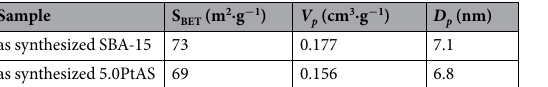
Table 2. Physicochemical properties of as synthesized SBA-15, and 5.0 PtAS samples before calcination.